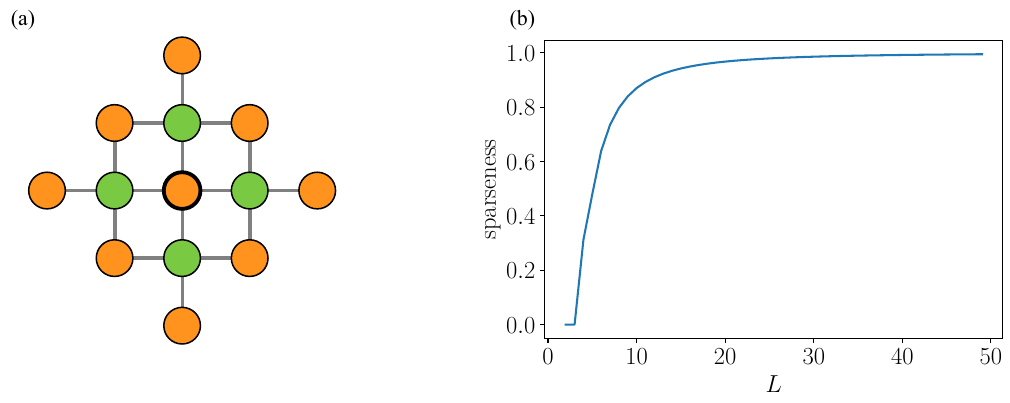
Figure 4. Sparseness of the matrix J in Eq. (8). ( a ) Nodes neighboring the reference node (green) and two nodes away from the reference node (orange) in a lattice graph. ( b ) Sparseness S J ( L ) of Eq. (13) for different numbers of intersections L